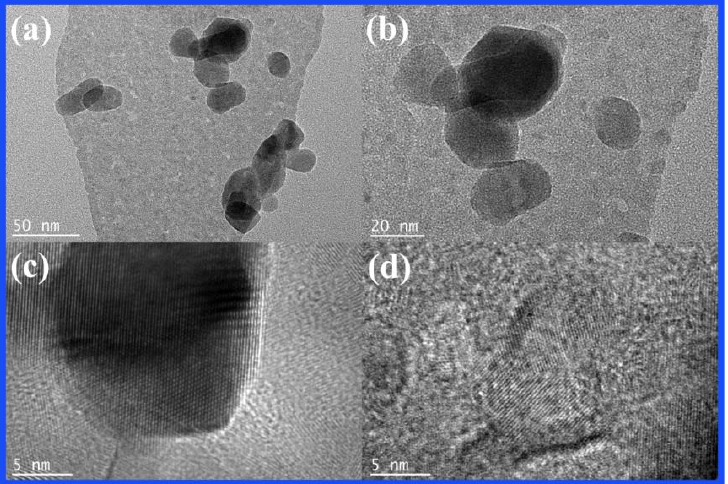
Figure 4. ( a , b ) TEM images of CN-200/Z-500 photocatalyst; ( c , d ) HR-TEM images of CN-200/Z-500 photocatalyst.